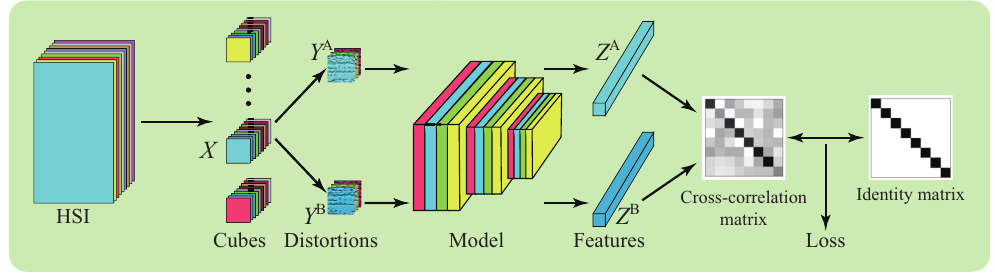
Figure 1. Illustration of the self-supervised training process of the proposed method.